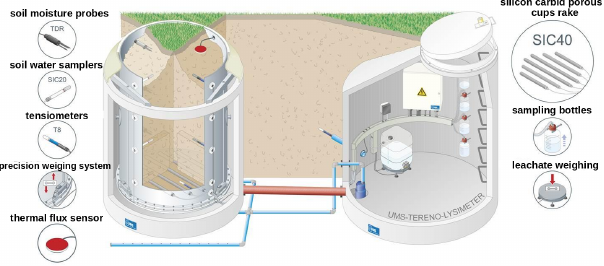
Figure 1. Schematic drawing of a lysimeter (left) as used in SoilCan attached to the central service pit